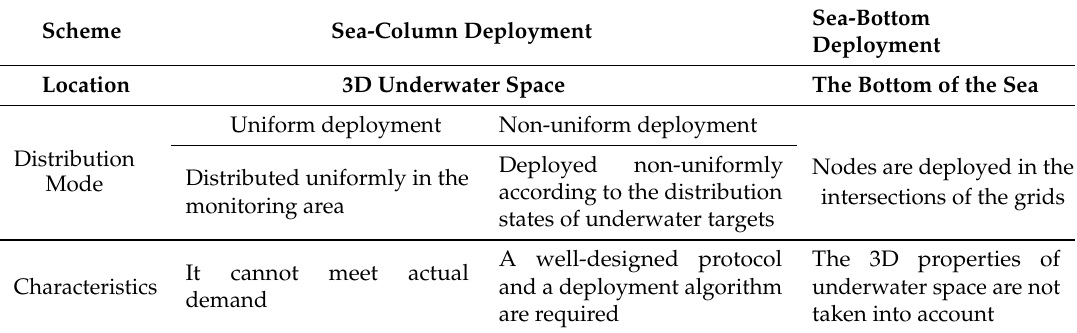
Table 1. Deployment classification of